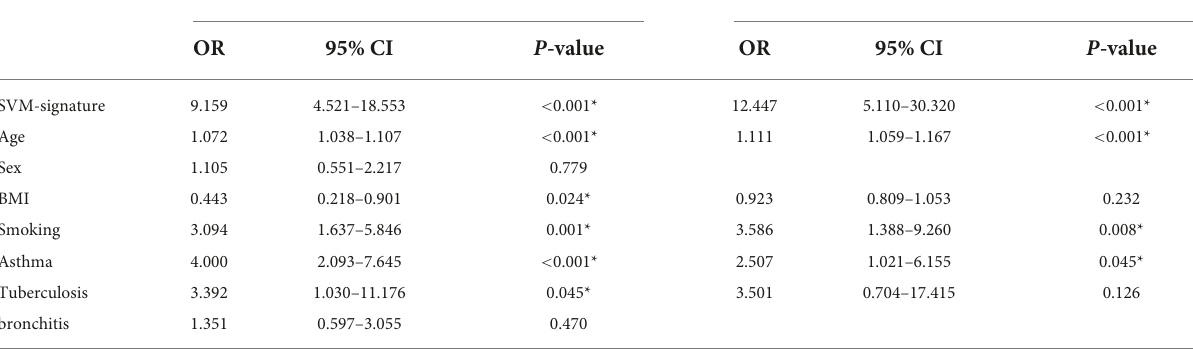
TABLE 4 Stepwise logistic regression analysis predicting small airway